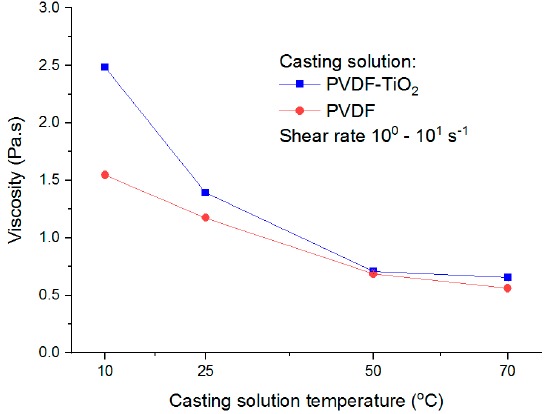
Figure 2. Viscosity of DMAc − based casting solutions at different temperatures.